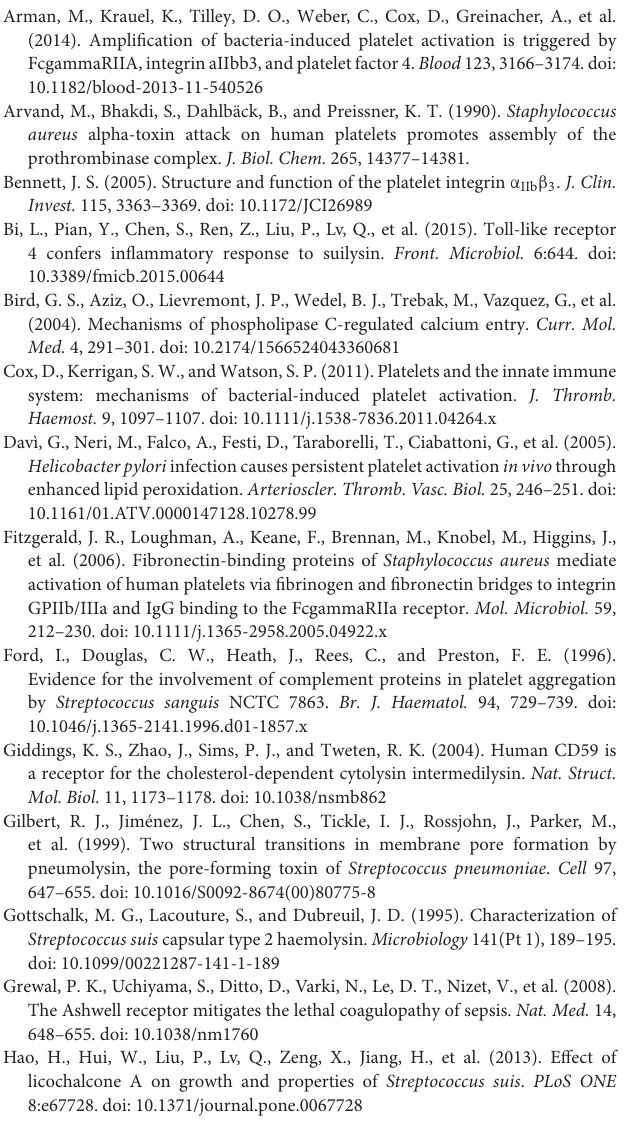
Figure S2 | The activity of S. suis -induced platelet aggregation. (A) The culture supernatant and the washed bacteria cells of S. suis were added to PRP in a stirred cuvette. Platelet aggregation was expressed as a final percentage of light transmission detected by Platelet Aggregometer se-2000. ADP (20 µ M) and THB were used as the positive controls and negative controls, respectively. Data are expressed as the mean ± SD of three independent experiments, with each experiment using blood from a different donor. (B) The platelet aggregation curves shown in panel B are from one representative experiment of three independent experiments. S. suis 4 (SLY + , 89K + ) isolated from human patient in China (2005); S. suis 4005 (SLY + , 89K − ) and s735 (SLY + , 89K − ) isolated from diseased piglets in Netherlands; S. suis 1940 (SLY + , 89K − ) isolated from diseased piglets in China (1980); Sup, supernatant; SLY, suilysin; 89K − , 89 kb pathogenicity island.